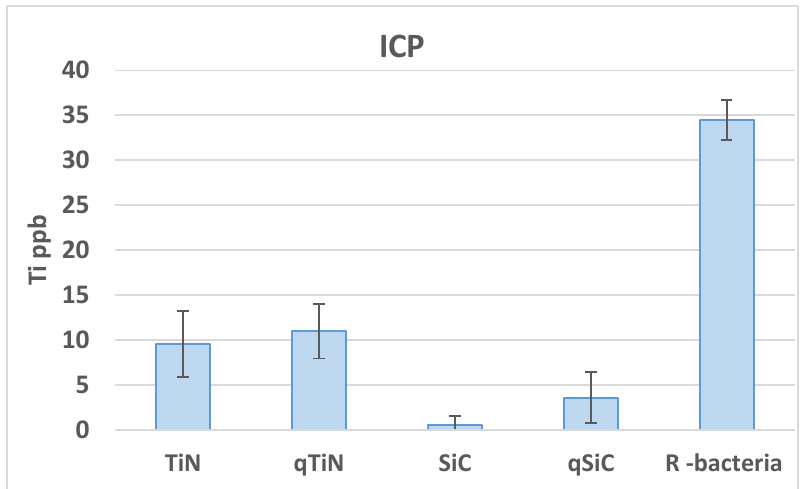
Figure 2. Ti ppb mean values and standard deviation in Ti disks non-coated (R bacteria) and coated (TiN, QTiN, SiC, and QSiC) samples.